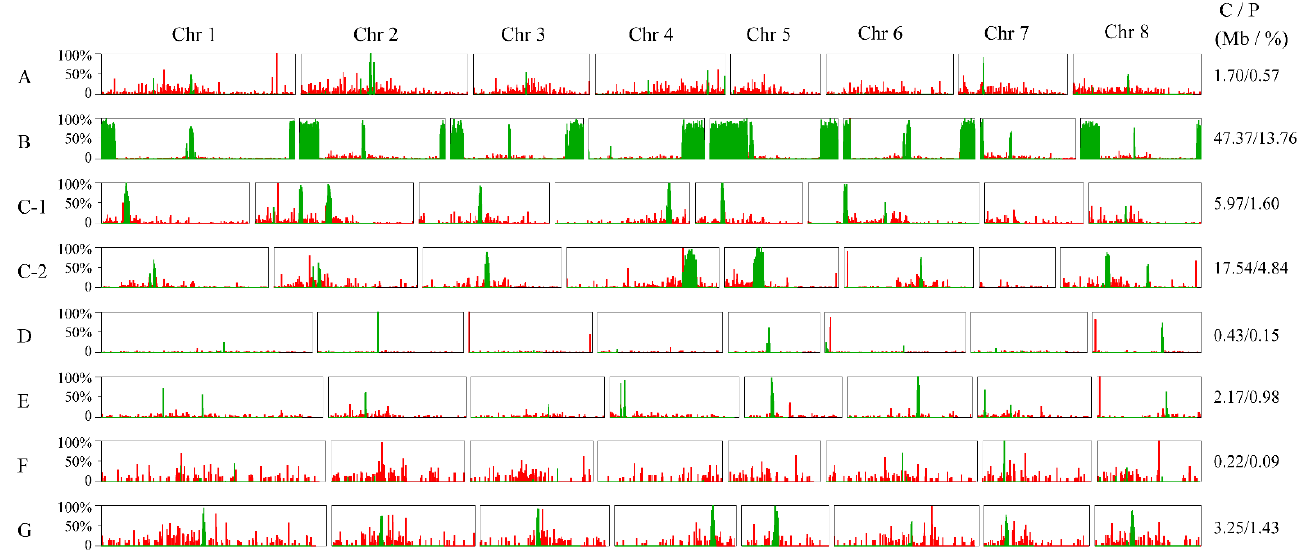
Figure 5. Distribution of centromere-associated and telomeric repetitive sequences on pseudochro- mosomes. Green and red bars represent the centromere and telomere sequences, respectively. The Y-axis indicates the percentage. (bin width: 100 k, step size: 50 k). ( A ) P. pseudocerasus ; ( B ) P. avium ; ( C-1 ) P. × yedoensis _spa; ( C-2 ) P. × yedoensis _spe; ( D ) P. salicina ; ( E ) P. armeniaca ; ( F ) P. dulcis ; and ( G ) P. persica . The contents and proportions of the centromere sequences are shown on the right side for each haploid genome. C represents contents (Mb); P represents percentages (%).